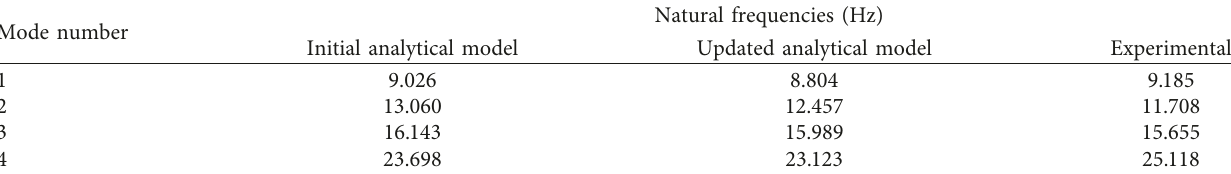
Table 4: Natural frequencies of the masonry building for initial and updated models.